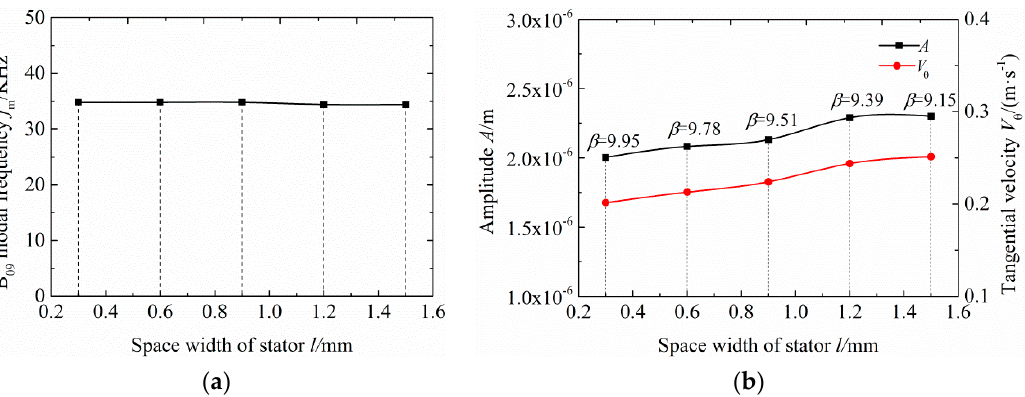
Figure 7. ( a ) Modal frequency affected by the space width of the stator and ( b ) amplitude affected by the space width of the stator.